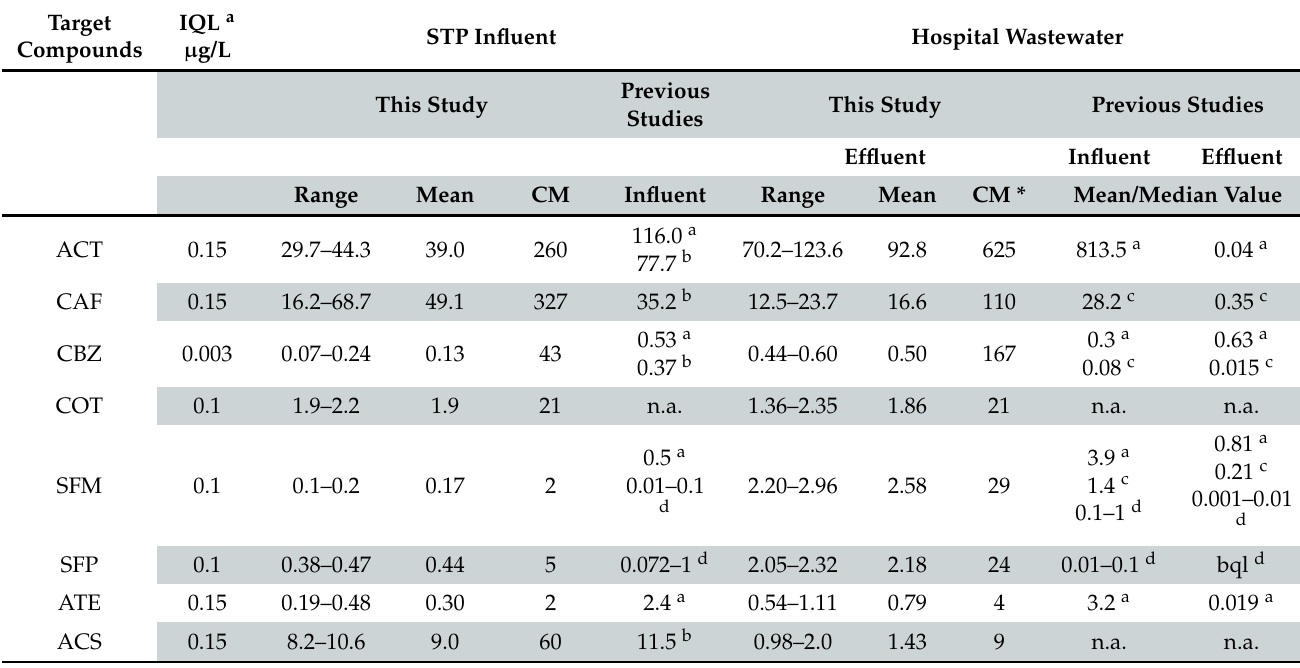
Table 2. Concentration ranges and means ( µ g/L) for wastewater compounds in urban STP influent and hospital effluent from this study ( n = 3) and three previous